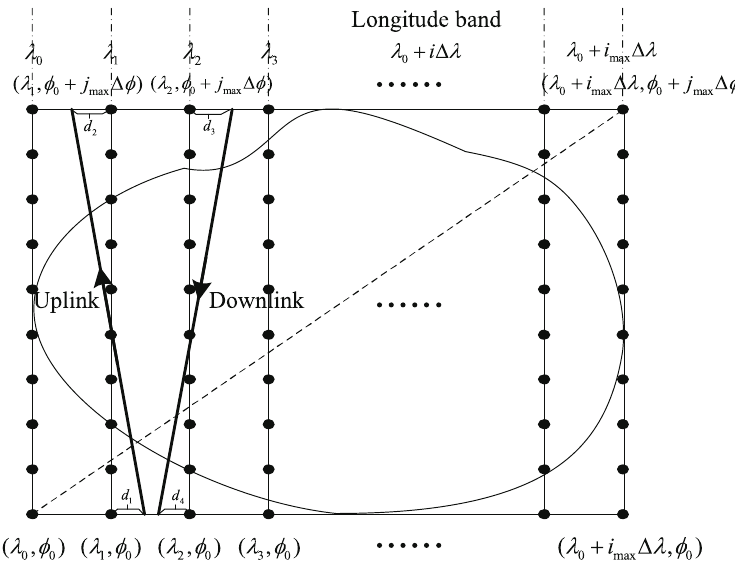
Figure 2: Schematic diagram of the optimization design process for a near - polar - orbit reference